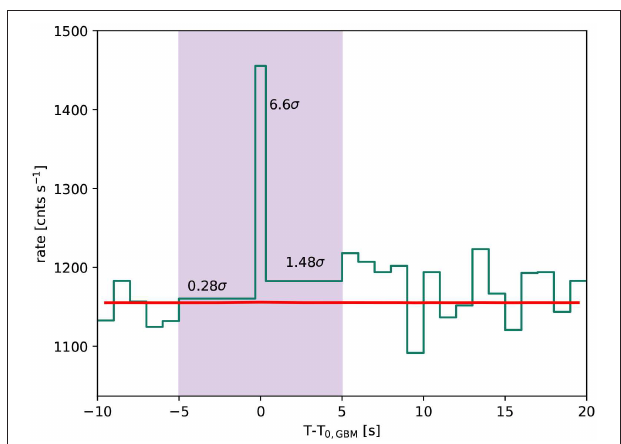
FIGURE 1 | The Bayesian-block binned count rate light curve of the GBM detected sGRB associated with GW 170817. The red line indicates the fitted background level and the shaded region indicates the times over which Bayesian blocks were applied. Additionally, the significance of the each temporal bin is